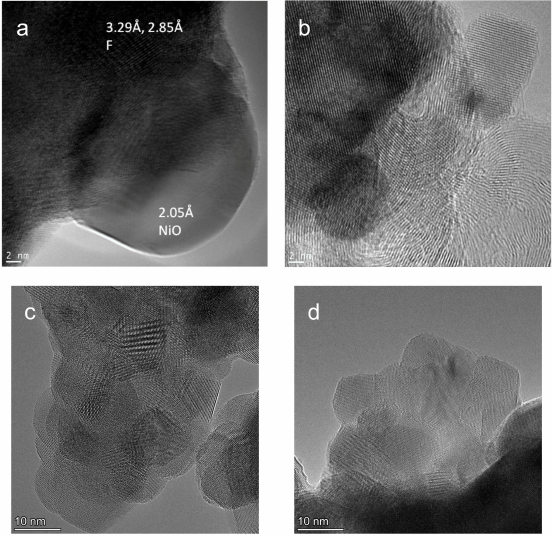
Figure 2. HRTEM images of composition NiCeTiNbZr prepared by impregnation ( a , b ) and one-pot synthesis ( c , d ) before (left column) and after (right column) tests in methane dry reforming. F denotes the fluorite phase, NiO denotes the nickel oxide phase; the corresponding interplanar distances are shown in the